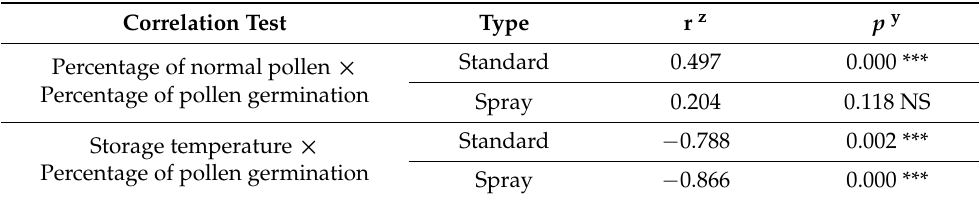
Table 4. Relationship between the percentage of normal pollen and the pollen germination rate after 30 days of storage at 26, 0, − 20, and − 72 ◦ C.